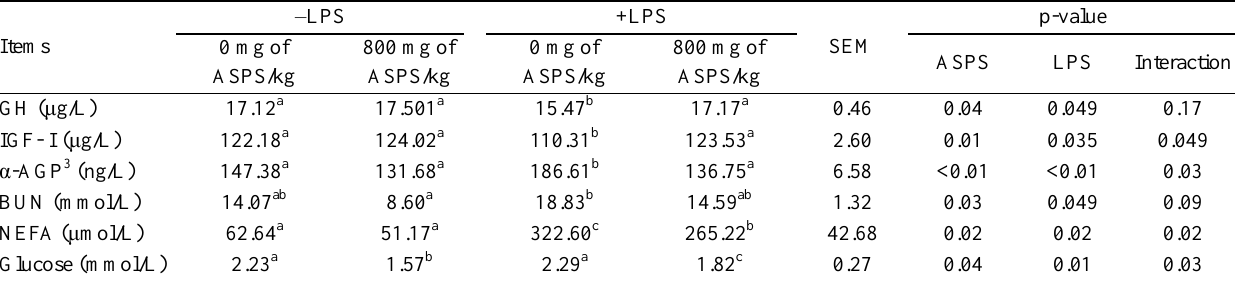
Table 5. Effect of dietary ASPS supplementation on some plasma parameters of weaned piglets challenged with LPS 1